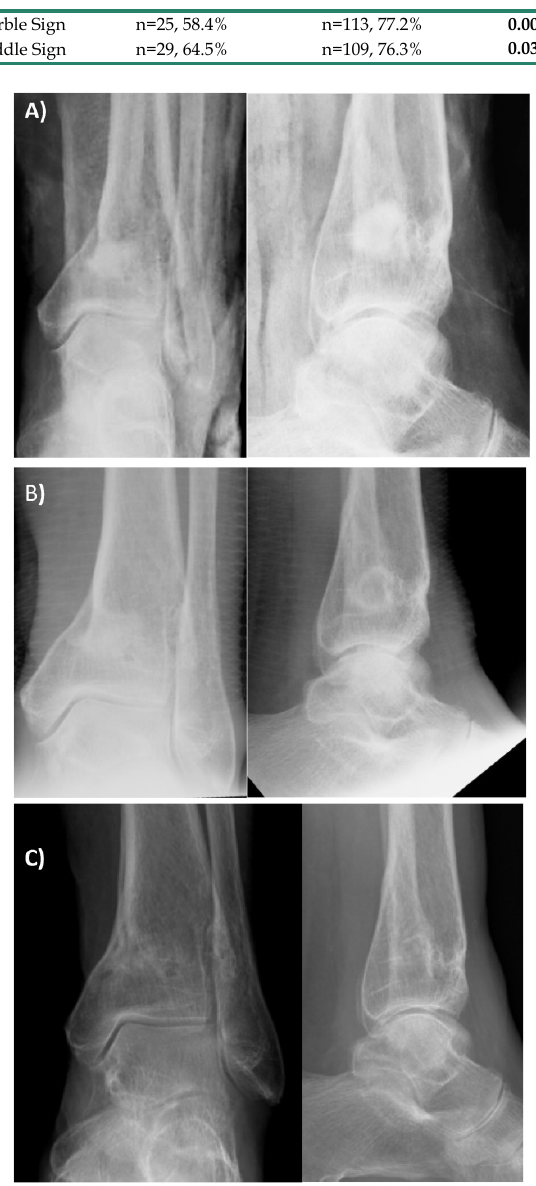
Figure 2. (A) Immediate post-operative follow-up radiographs (AP and lateral view) after debridement and filling of an osteomyelitic bone defect of the distal tibia. (B) Follow-up radiographs (AP and lateral view) six weeks following surgery. Note “Halo sign” in lateral view at six weeks. (C) Images taken 12 months following surgery. There is almost complete filling of the void with new